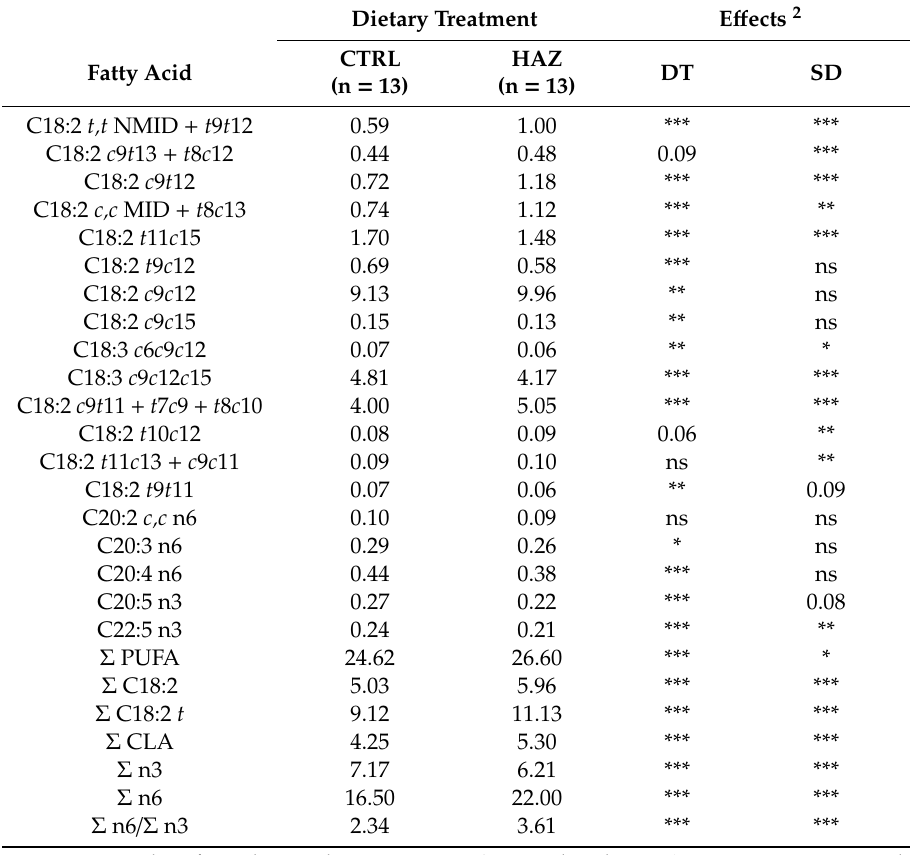
Table 6. Polyunsaturated fatty acids (g / kg fat) in milk of cows fed the control (CTRL) and hazelnut skin (HAZ) diets 1 . Dietary